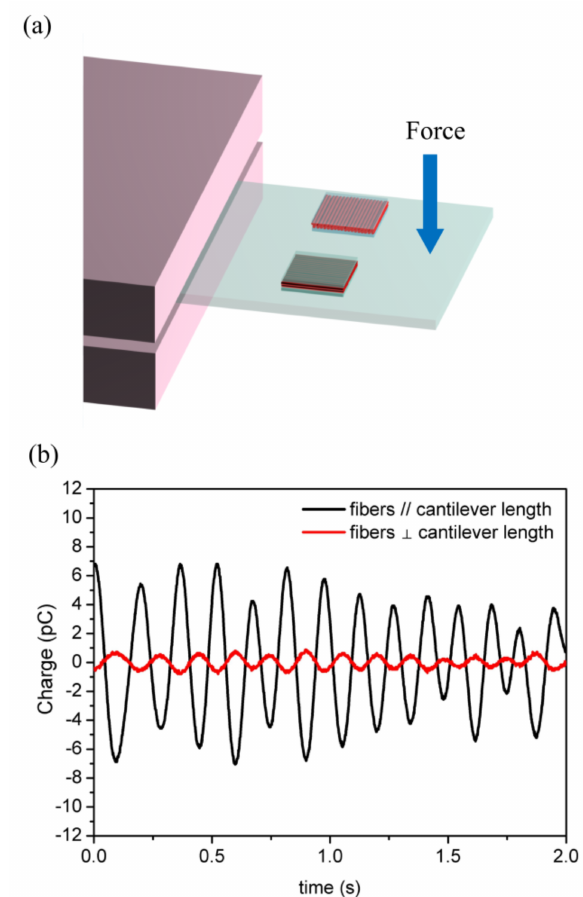
Figure 6. ( a ) Schematic illustration of the directional strain-sensing measurements. ( b ) Piezoelectric charge outputs with their fiber alignment directions parallel and perpendicular to the cantilever length